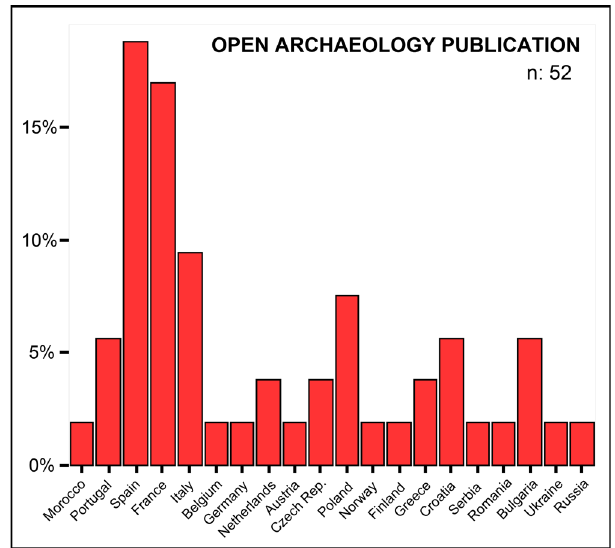
Figure 4: Breakdown by countries of the geographical regions covered by the presentations fi nally published in the journal Open Archaeology .